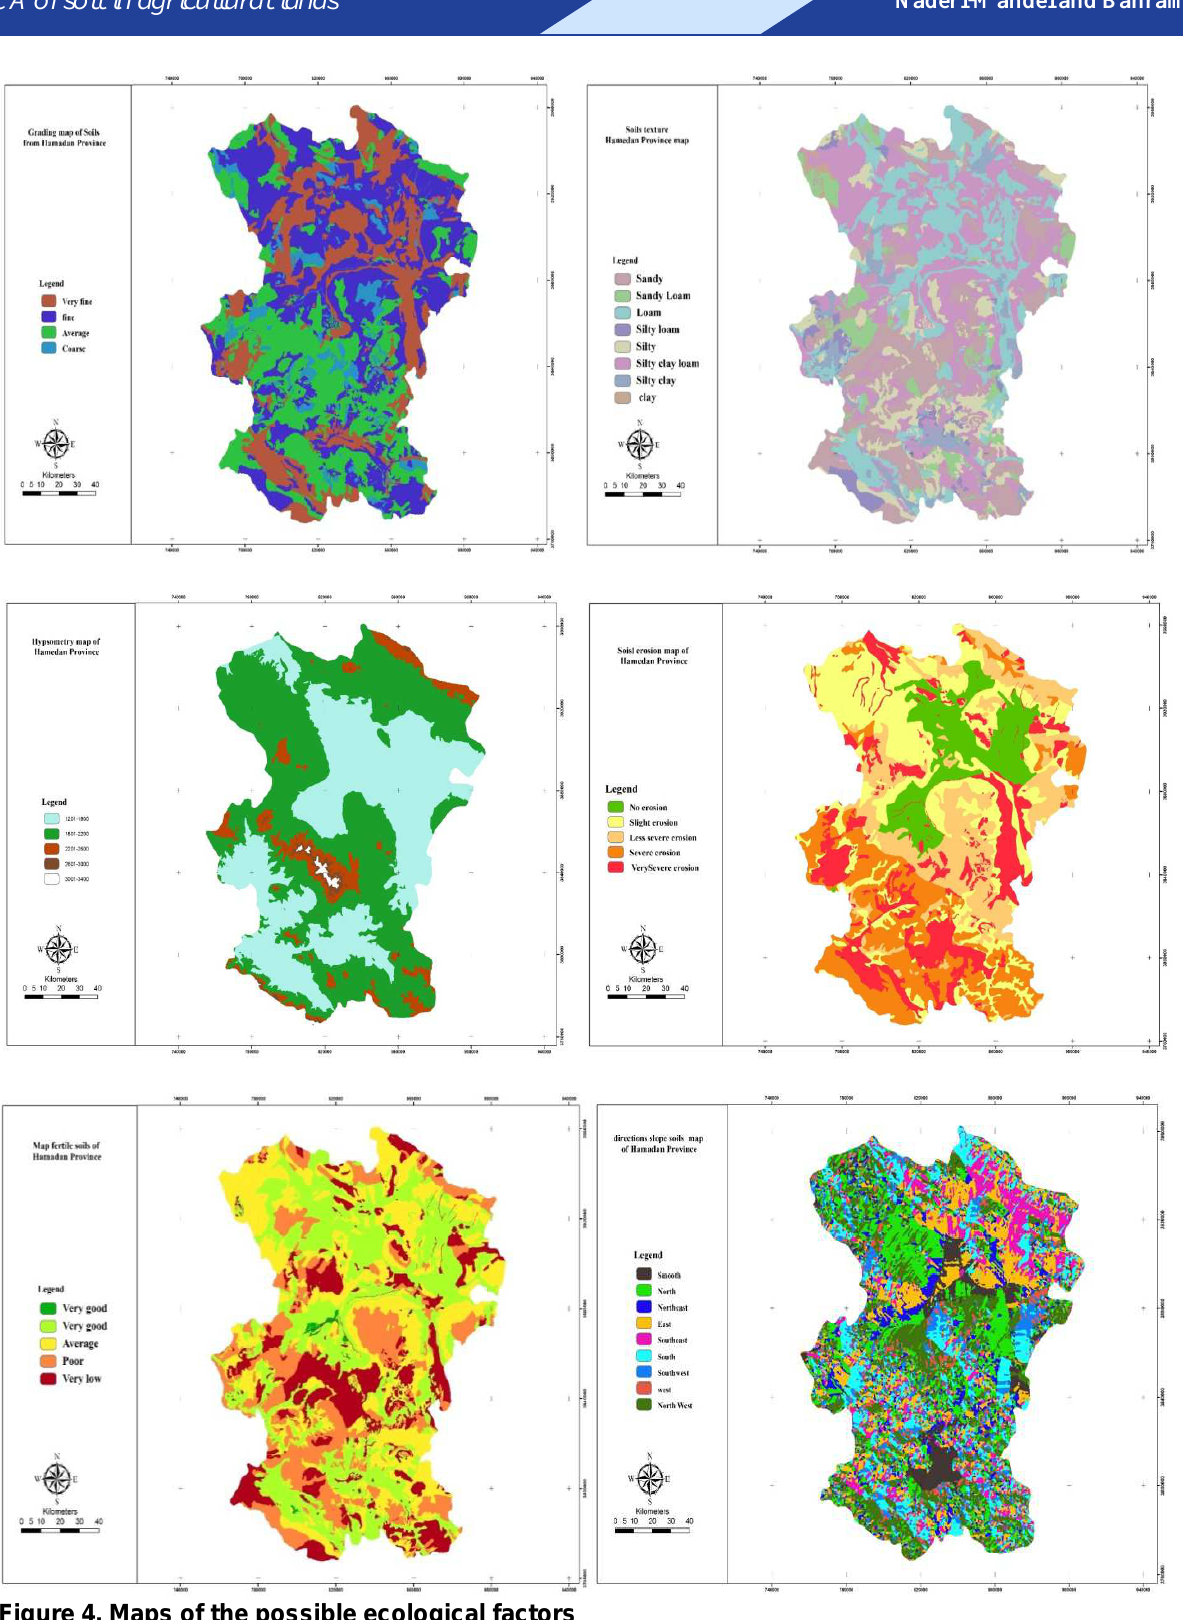
Figure 4. Maps of the possible ecological